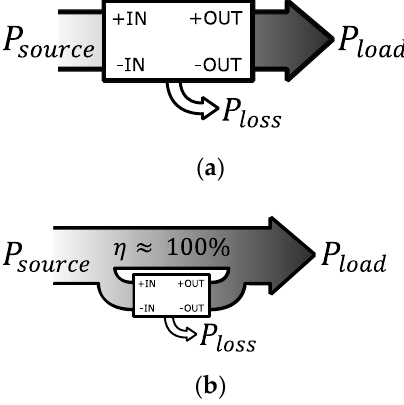
Figure 2. Power flow diagram. ( a ) FPP; ( b ) PPP.